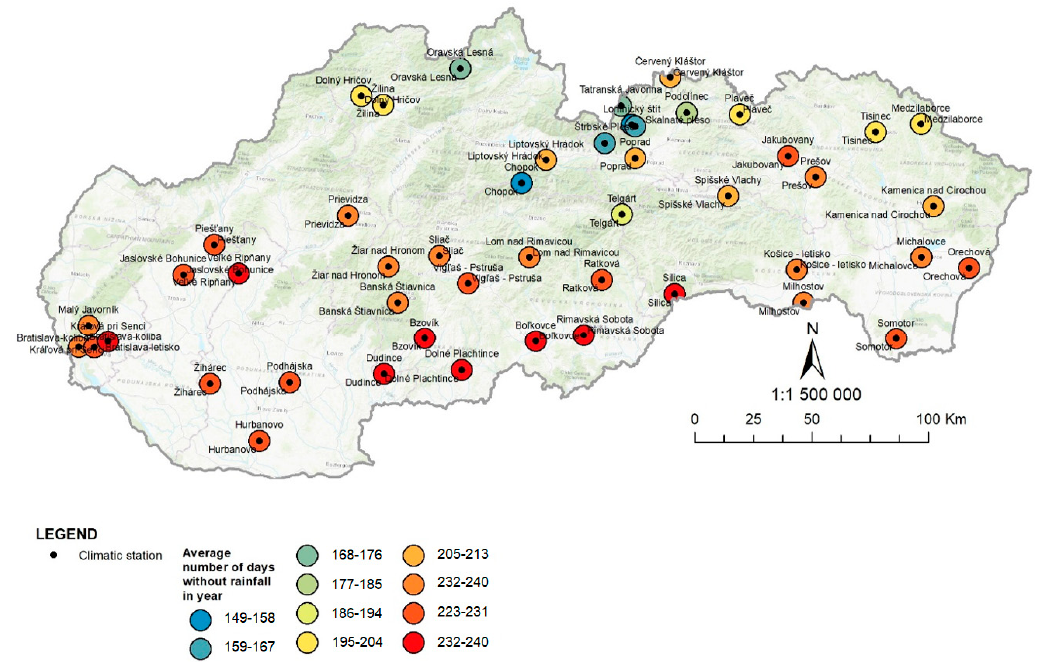
Figure 5. Average number of days without precipitation.